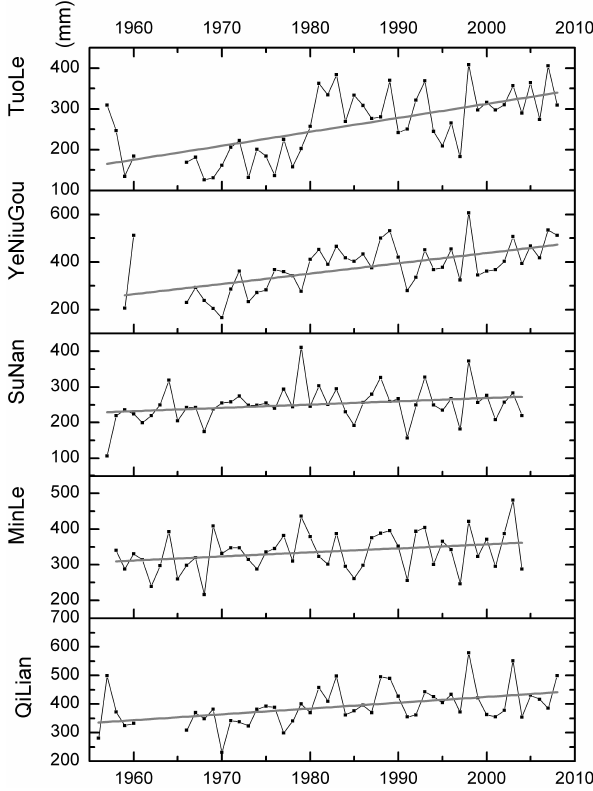
Fig. 5. Annual precipitations of 5 meteorological stations from 1956 to 2008.